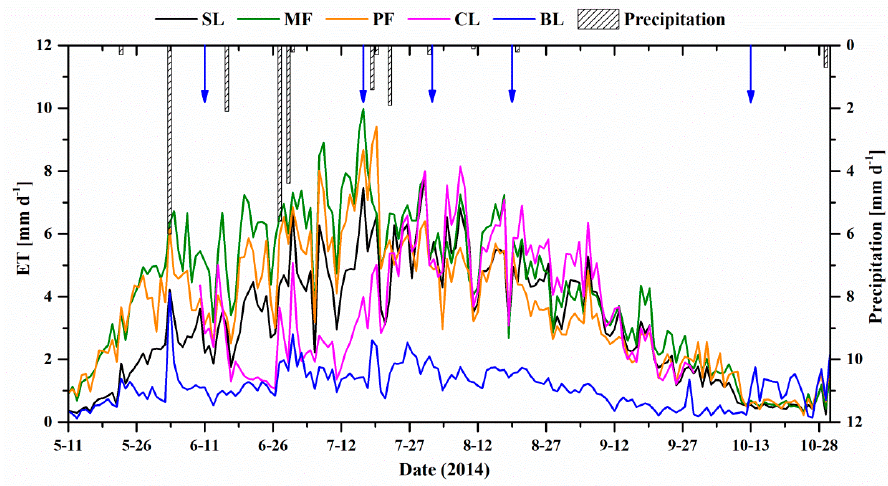
Figure 8. Temporal variation in daily ET at five EC sites for the five and half months in 2014. The blue arrows represent irrigations during the growing season. The legend is consistent to Figure 4.